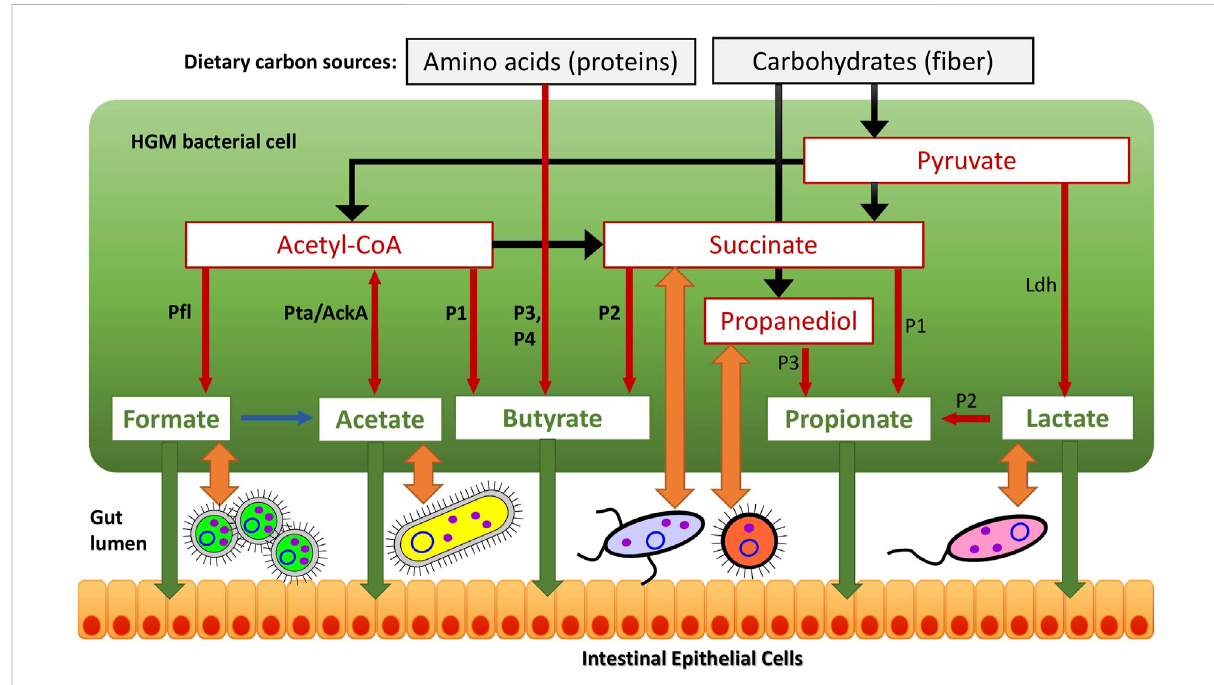
FIGURE 8 Metabolic pathways and cross-feeding mechanisms for SCFA production by HGM bacteria. Terminal SCFAs and lactate are in green. Dietary nutrientsandcoremetabolicprecursorsareinblackandred,respectively.MicrobialSCFAfermentationpathwaysanalyzedinthisworkareshownby red arrows. Carbohydrate catabolic pathways are in black. Wood-Ljungdahl pathway is in blue. Absorption of terminal SCFAs by intestinal epithelial cells is shown by thick green arrows. Cross-feeding interactions between HGM members are shown by thick orange